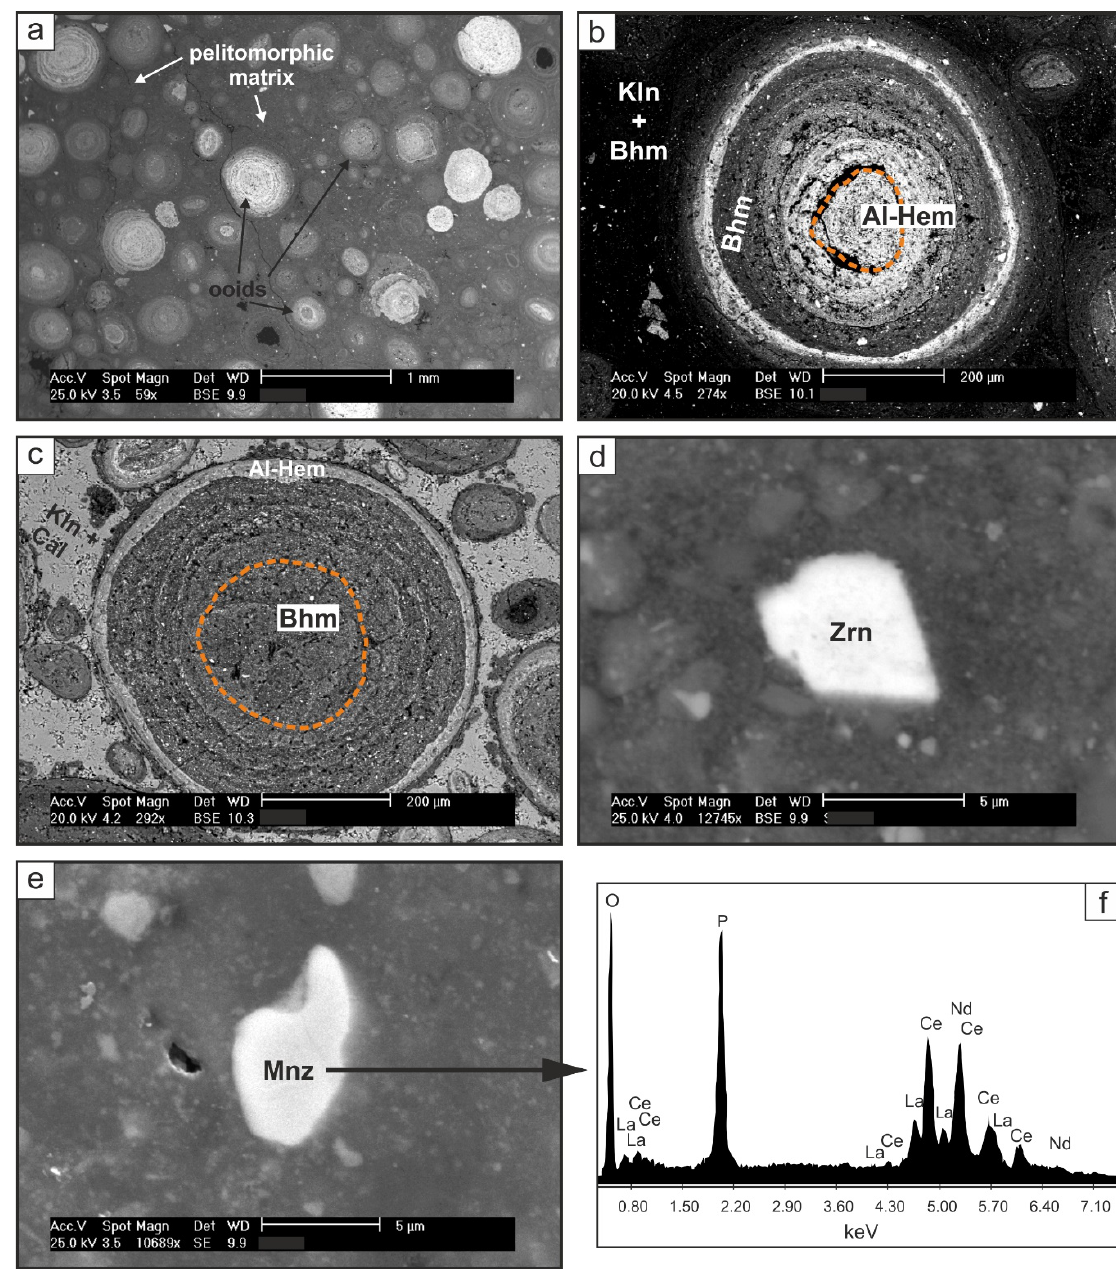
Figure 4. SEM images showing the principal microscopic features of the SGR bauxite. ( a ) ooidal texture formed by a pelitomorphic matrix and variable-sized spherical concretions, ( b ) an ooid with an authigenic hematite nucleus (highlighted by the orange dashed line), ( c ) an ooid with an authigenic boemite nucleus (within the orange dashed line), ( d ) detrital zircon and ( e ) monazite embedded in the matrix, ( f ) EDS results for the monazite shown in (e). Al-Hem = Al-hematite, Bhm = boehmite, Cal = calcite, Kln = kaolinite, Mnz = monazite, Zrn = zircon.